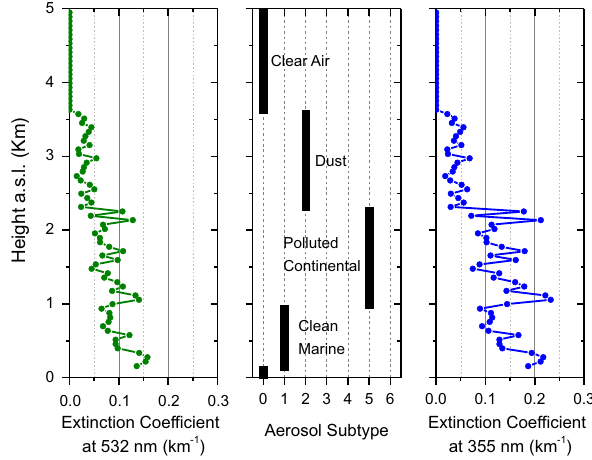
Figure 8. CALIPSO Level 2 extinction coefficient profile at 532nm (left), aerosol type (center) and converted extinction coefficient at 355nm (right), based on LIVAS typical EAEs. The profile example refers to 7 September 2011 (cell centroid with latitude of 37.5 ◦ and longitude of 20.5 ◦